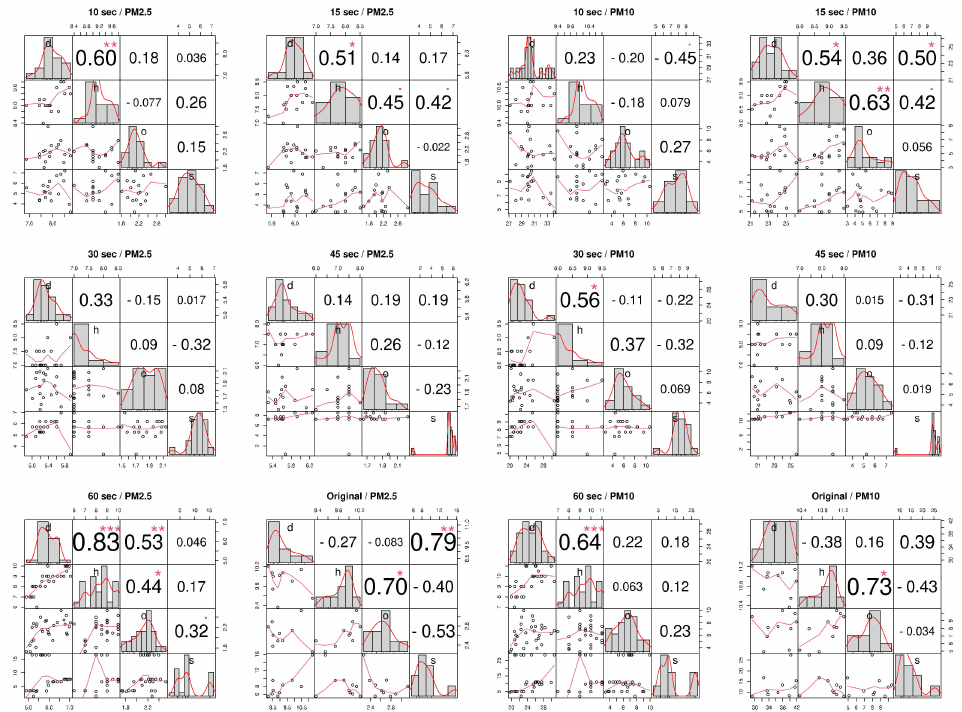
Figure 4. Lab measurement correlation matrix between four COTS sensors, for two particle size classes (PM.25 and PM10) and six measurements lag intervals (10, 15, 30, 45, 60 s and “original”). (H = Honeywell, D = Dylos, O = OPC, S = Sharp). Astrix denotes the signifiance level: * < 0.05, *** < 0.001, ** <